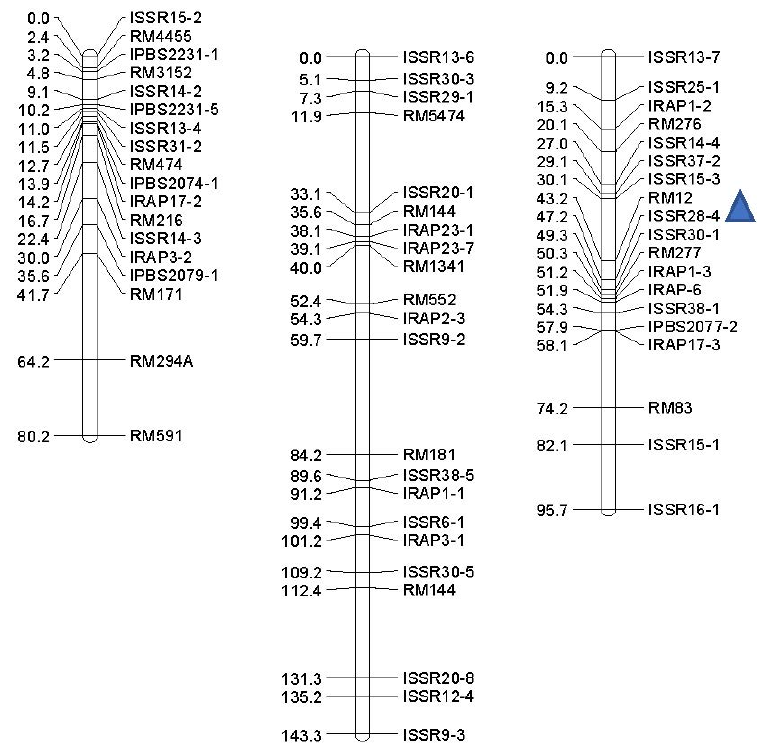
Figure 3. Location of controlling drought tolerance traits in the F8 population of O. sativa at the germination stage.